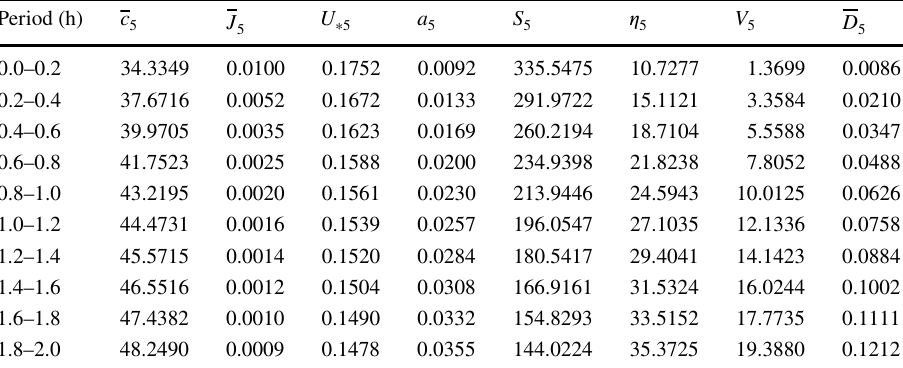
Table 7 Hydraulic parameters, sediment settling rates and average siltation thickness values of the fifth calculation segment